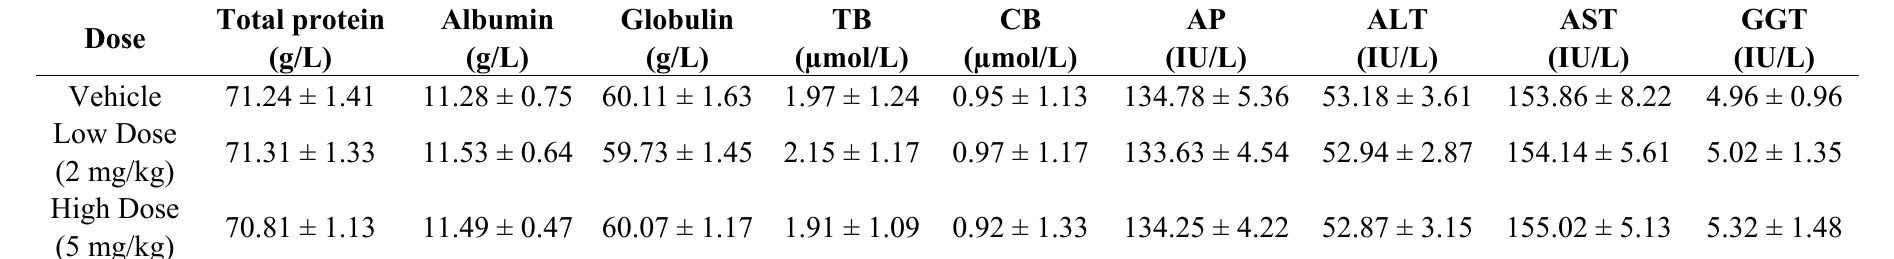
Table 6. Effect of adiponectin on liver function test in acute toxicity